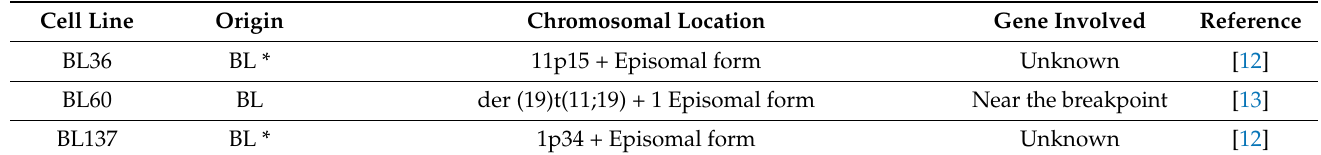
Table 1. EBV integration sites reported in 8 BL-CLs, 24 EBV-transformed lymphoblastoid cell lines (LCLs), and 1 Hodgkin lymphoma cell line at chromosomal band resolution